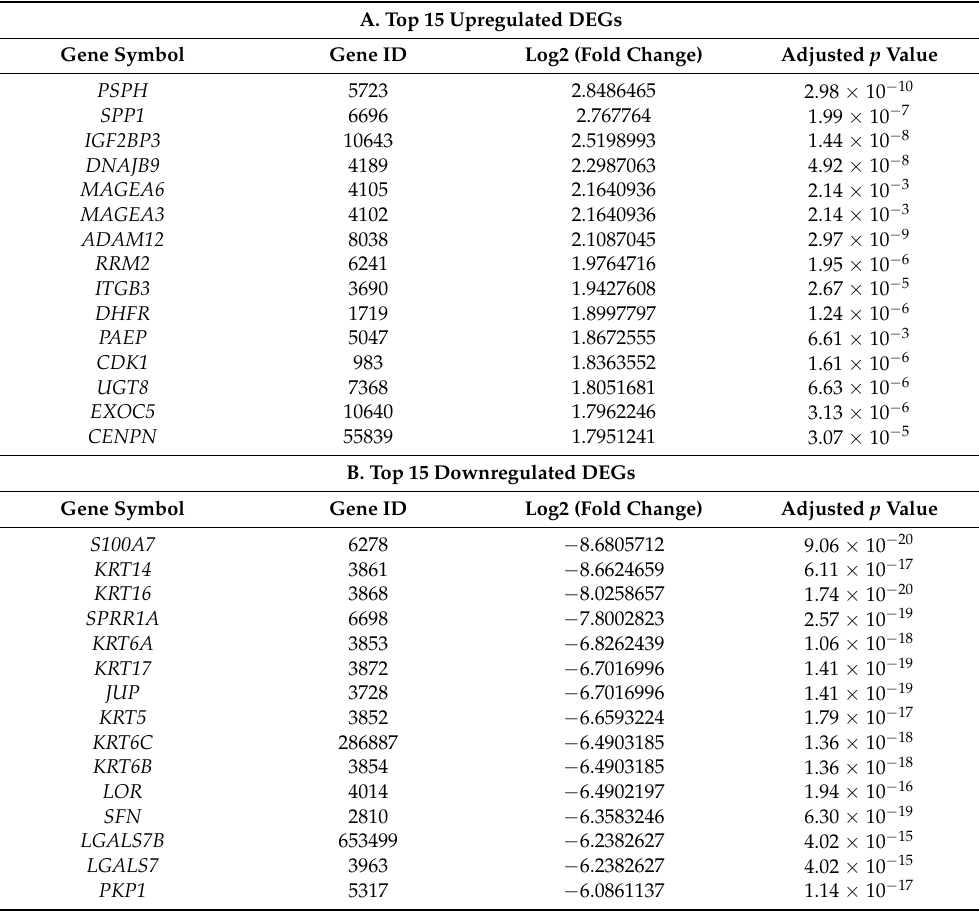
Figure 1. ( A ) Heat map visualization showing alternation for the full range of gene expression patterns between melanoma metastases and primary melanoma. Purple indicates upregulated genes, and green indicates downregulated genes. ( B ) The volcano plot shows the genes expressed significantly differentially between melanoma metastases and primary melanoma. Purple indicates the upregulated genes, and green indicates the downregulated genes. Table 1. Selected DEGs between primary melanoma and metastatic